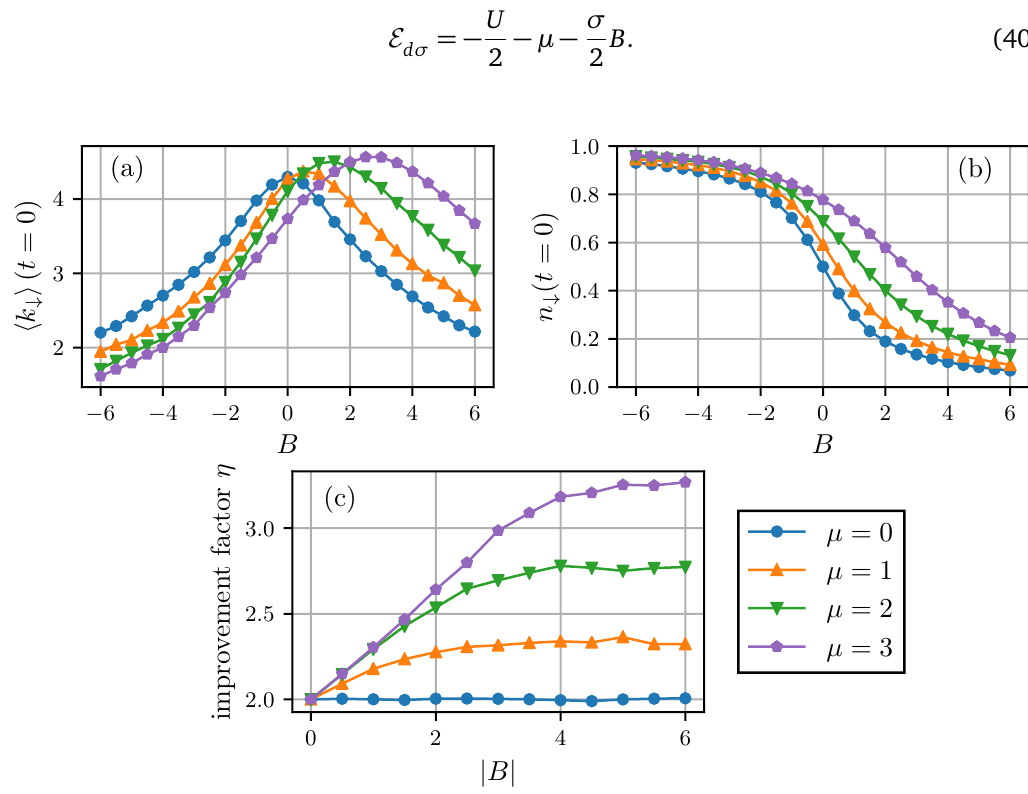
Figure 5: (a) Equilibrium average CT-1 / 2-HYB expansion order vs. magnetic field B . (b) Equilibrium spin-down impurity level filling n ↑ as a function of magnetic field B and chemical potential µ . Spin-up filling is obtained by the mirror symmetry around B = 0. (c) Improvement factor η as a function of | B | . All the results are for N =